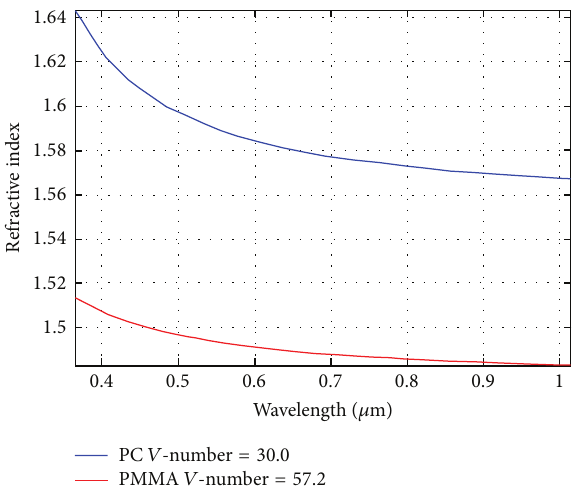
Figure 1: Refractive index of PC on